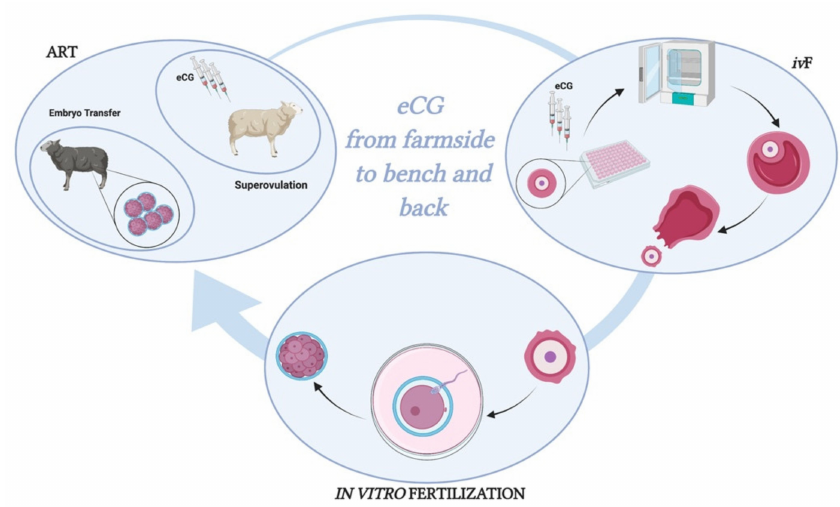
Figure 9. eCG: from farmside to bench and back. Figure created with BioRender. Available online: https://biorender.com/ (accessed on 15 November